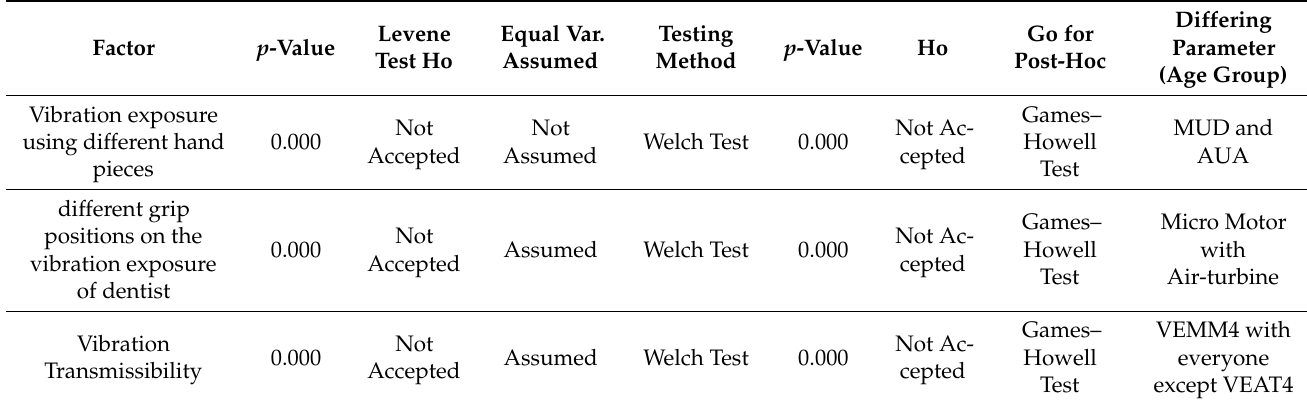
Table 12. Summarized objectives of the